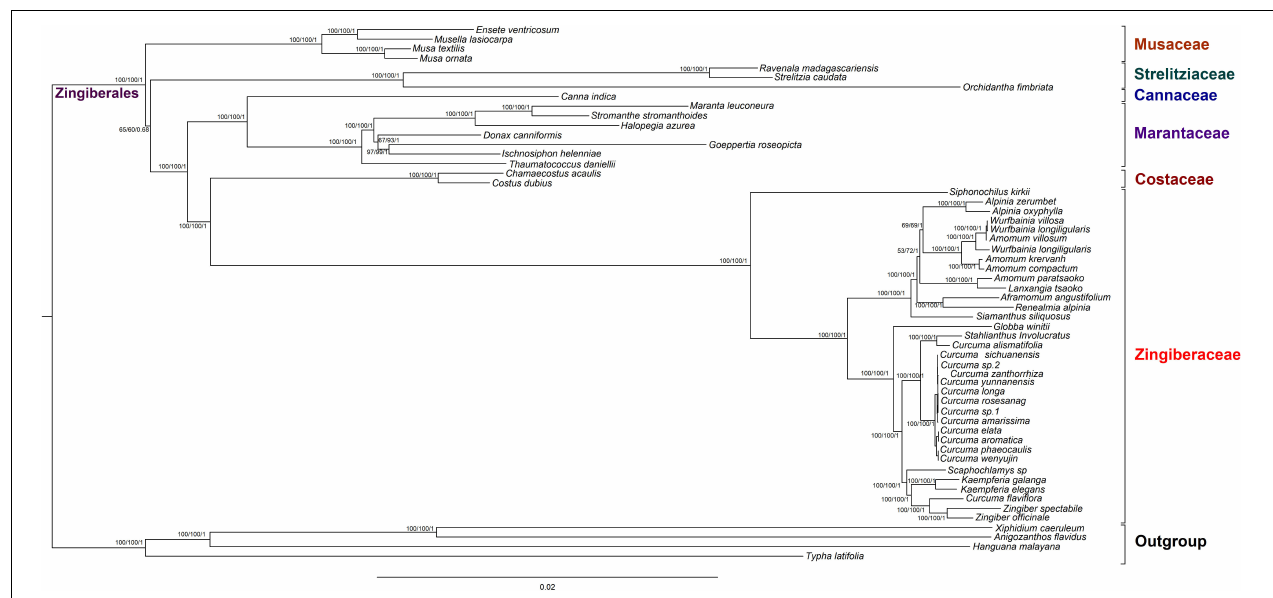
FIGURE 7 | Phylogenetic relationships of 52 Zingiberales species taxa inferred from Maximum Parsimony (MP), Bayesian Inference (BI), and Maximum Likelihood (ML) analyses of protein-coding genes. Xiphidium caeruleum , Anigozanthos flavidus , Hanguana malayana, and Typha latifolia was used as the outgroup. Numbers above nodes are support values with MP bootstrap values on the left, ML bootstrap values in the middle, and Bayesian posterior probabilities (PP) values on the right.